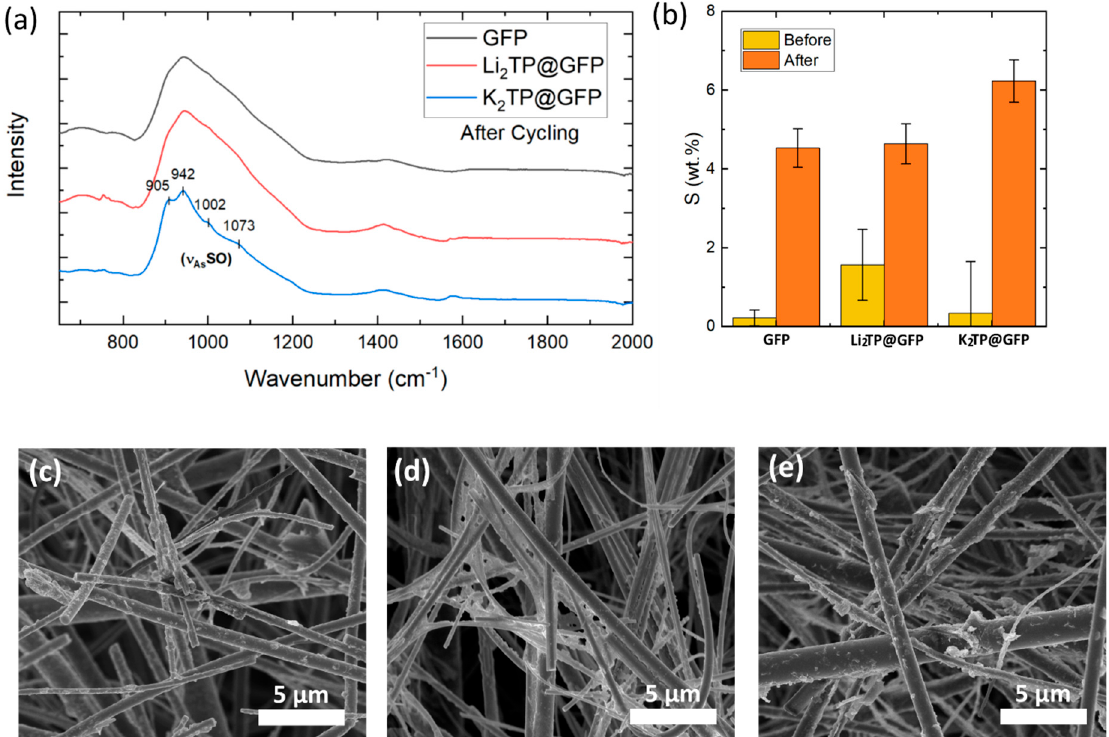
Figure 5. Post-mortem analysis of modified and unmodified separators cycled in LSBs including ( a ) FTIR, ( b ) EDS sulfur quantitative analysis, and SEM of ( c ) GFP, ( d ) Li 2 TP@GFP, and ( e ) K 2 TP@GFP.